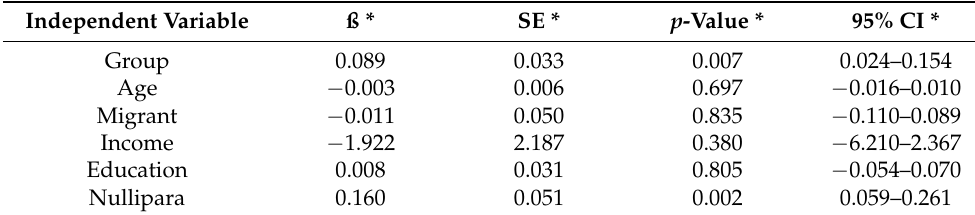
Table 3. Multiple regression analysis using GEE (dependent variable: ∆ knowledge, n = 1016). Independent Variable ß